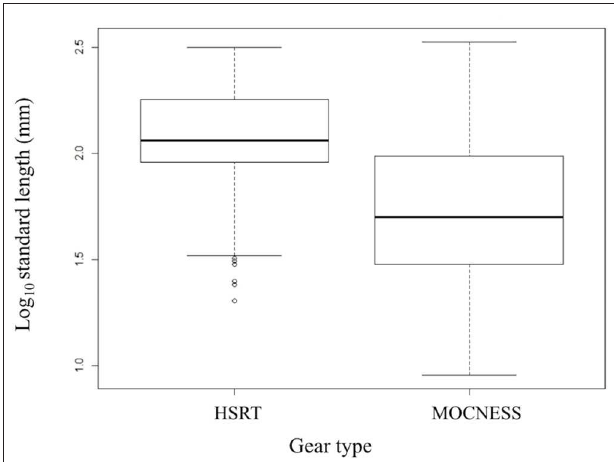
FIGURE 6 | Boxplot comparing the size distributions of the 12 dominant stomiid species collected with the HSRT and MOCNESS in the Gulf of Mexico. Bolded horizontal lines indicate the median, and boxes represent the interquartile range (IQR), with the top and bottom lines indicating the 75th and 25th percentile, respectively. Whiskers represent minimum and maximum values no more than 1.5 times the IQR (upper value = 75th percentile + 1.5 × IQR, lower value = 25th percentile – 1.5 × IQR). Open circles represent outliers and indicate smaller fish were caught. HSRT, High-Speed Rope Trawl; MOCNESS, Multiple Opening/Closing Net and Environmental Sensing